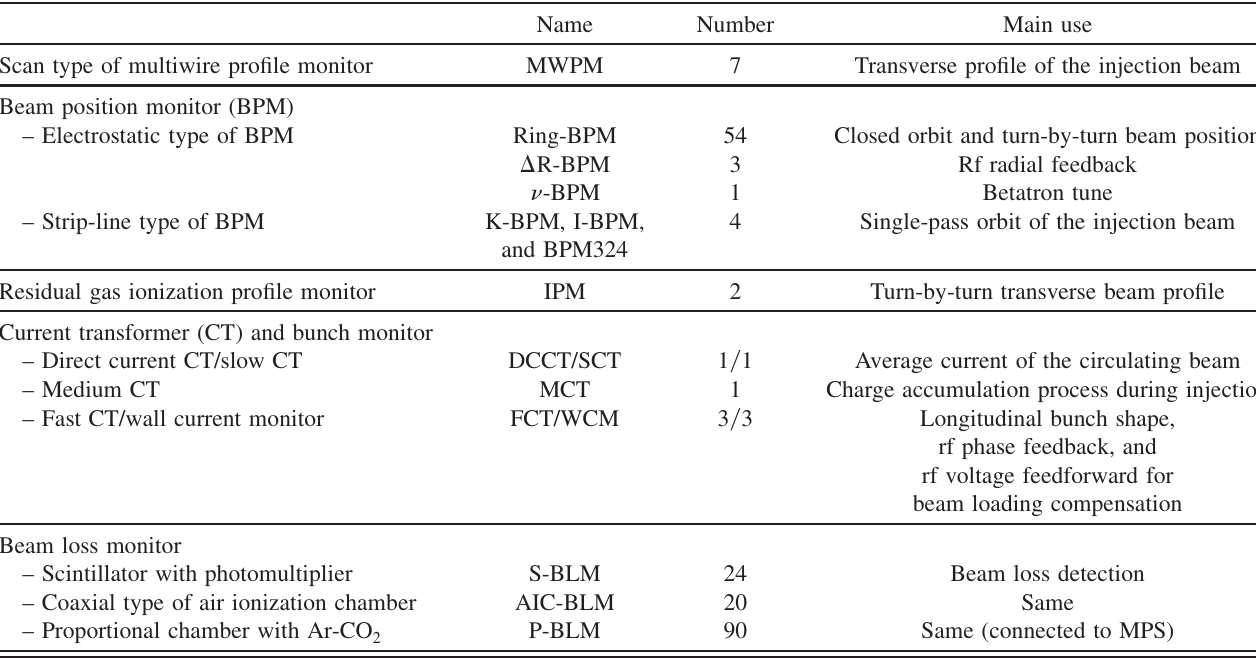
TABLE II. Beam diagnostics system employed in the RCS beam